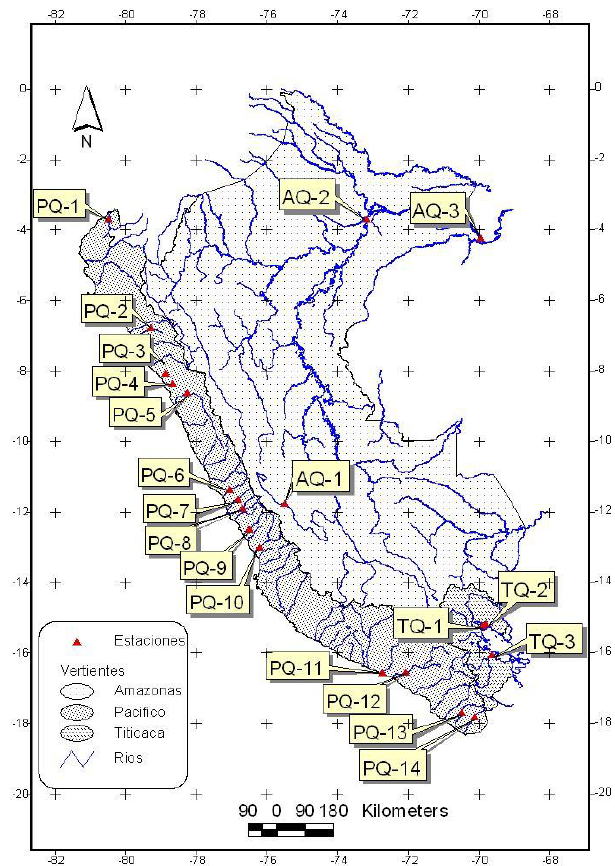
Figure 1. Spatial location of the hydrometric stations used in this study: in the Pacific Coast (PQs); Titicaca Lake (TQs) and Amazonas (AQs).